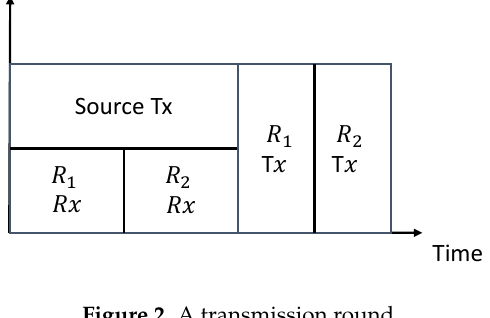
Figure 2. A transmission